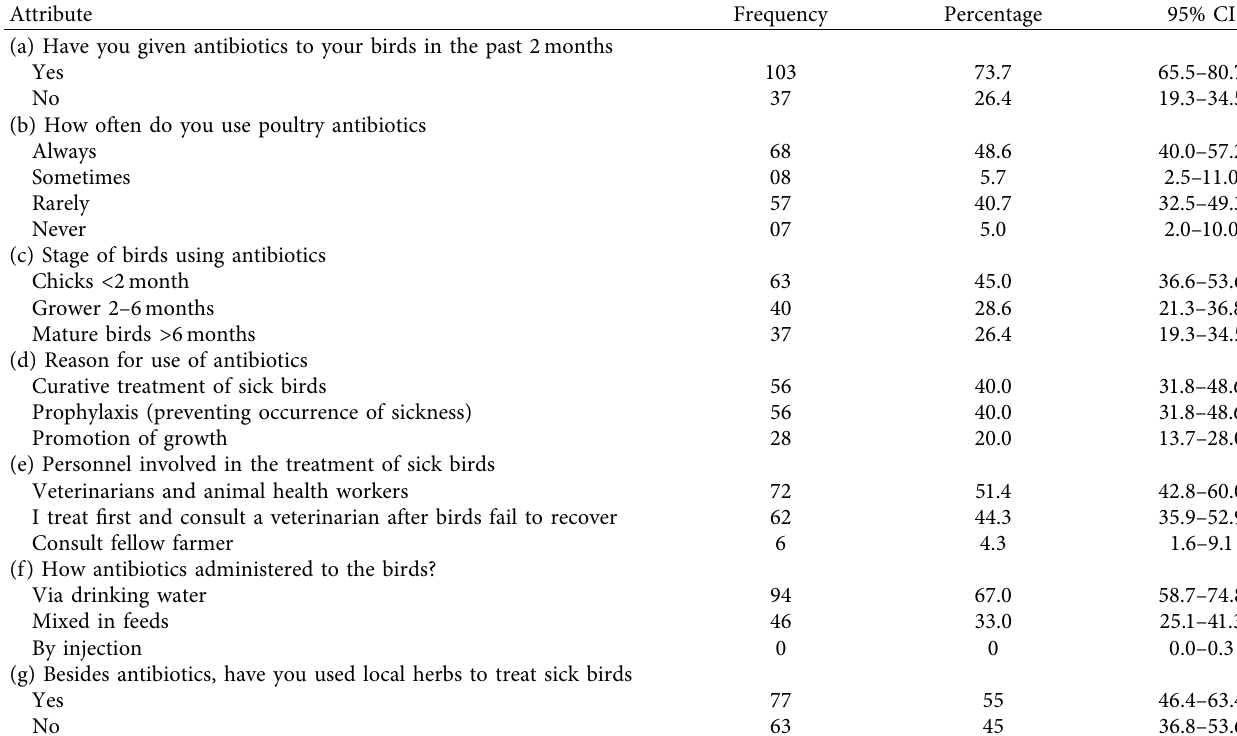
Table 2: Antibiotic use practices in poultry